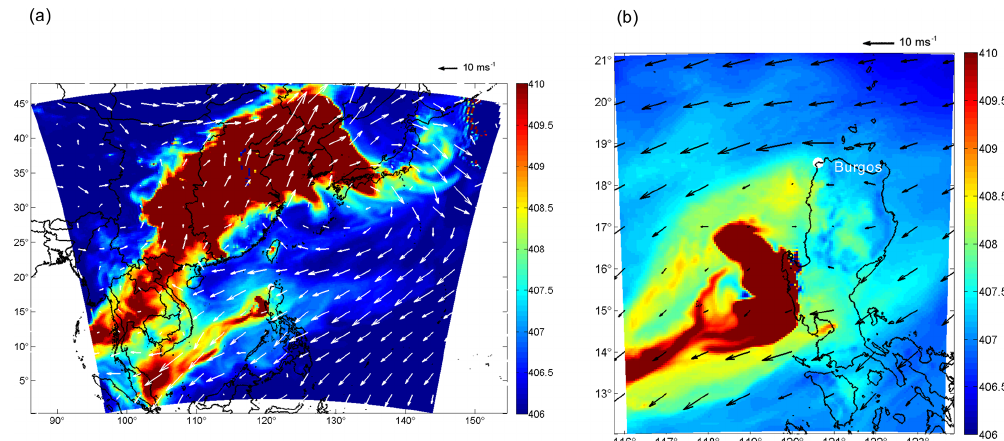
Figure 4. (a) Mean CO 2 mole fractions and wind vectors from the surface to 3km altitude over Japan, Korea, China, Taiwan, and parts of Southeast Asia at 09:00UTC on 12 March 2018, simulated by the Weather Research and Forecasting Model. (b) Same as (a) but for a magnified section over the Philippines at